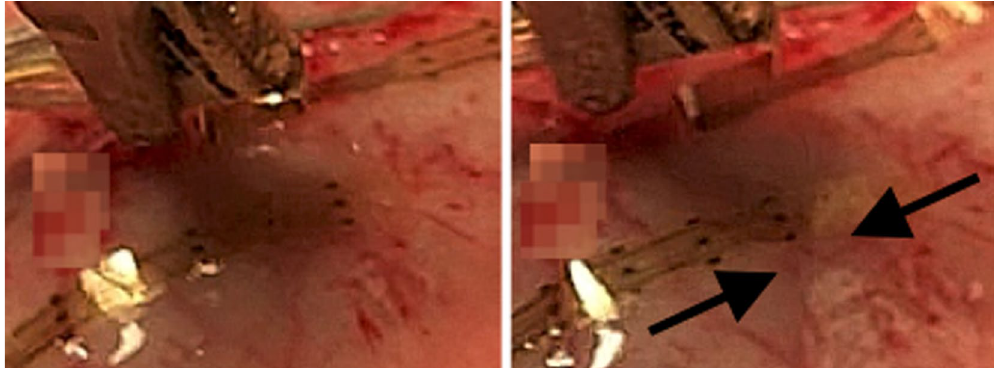
Figure 3. Longitudinal contraction of the distal colonic tissue in responses to direct distal colon stimulation. Left: Before stimulation. Right: During